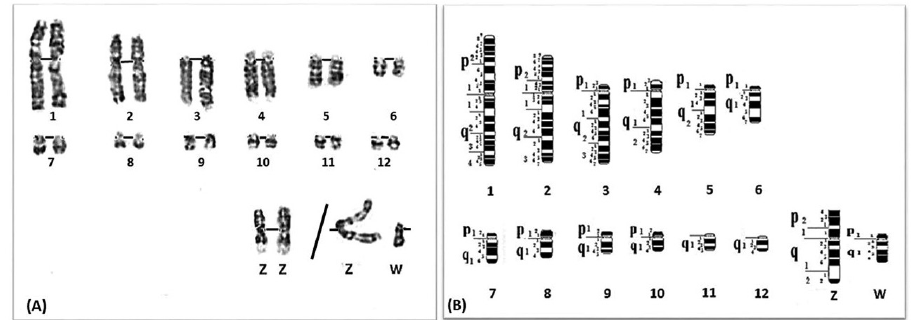
Figure 2. A GTG-banded karyotype for pairs 1 to 12 and sex chromosomes of the Common quail Coturnix coturnix . B Idiogram corresponding to A